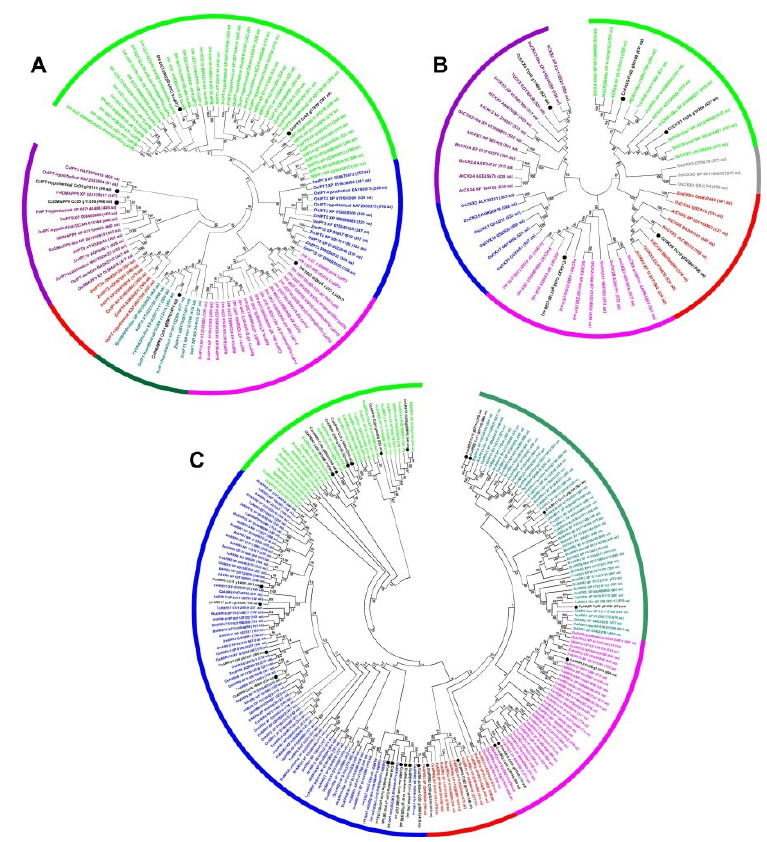
Figure 1. Phylogenetic trees of the CK homeostasis proteins from Coffea canephora Cc, Arabidopsis thaliana At, Brassica napus Bn, Capsicum annuum Ca, Citrus sinensis Cs, Daucus carota Dc, Fragaria vesca Fv, Ipomoea triloba It, Jatropha curcas Jc, Nicotiana attenuate Na, Oryza sativa Japonica Os, Phaseolus vulgaris Pv, Pisum sativum Ps, Prunus dulcis Pd, Solanum lycopersicum Sl, Theobroma cacao Tc and Zea mays Zm. The neighbor-joining method of the MEGA 7.0 program was used to construct the phylogenetic trees; the bootstrap was 1000 replicates: ( A ) the phylogenetic tree of IPT proteins; ( B ) the phylogenetic tree of CKX proteins; ( C ) the phylogenetic tree of ARR proteins. The different colors indicate different groups of proteins. The black letters and black circles show the proteins of C. canephora , and the length of amino acids is indicated in parentheses.